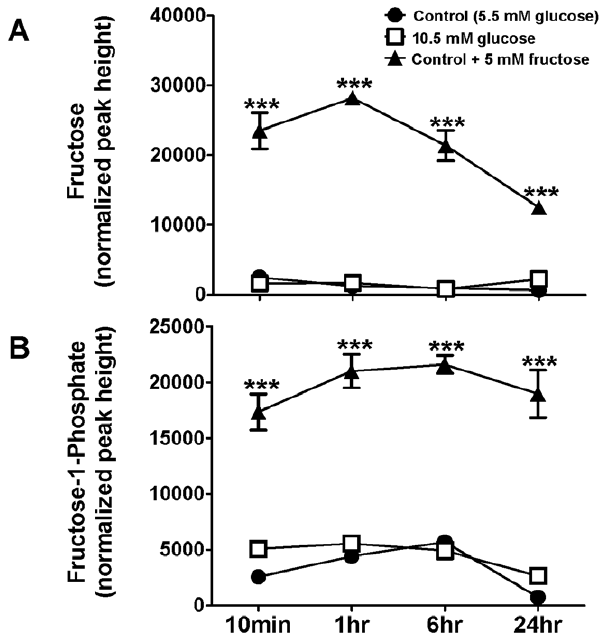
Figure 3. Cellular concentrations of UDP-GlcNAc in HepG2 cells following exposure to glucose and fructose or glucose alone. LC-QTOF results for cellular levels of UDP-GlcNAc in HepG2 cells at 10 min, 1 hr, 6 hr, or 24 hr time points following the addition of culture medium. The 10 mM GlcN condition, serving as a positive control, showed significant induction of the hexosamine biosynthesis pathway (HBP). Unit of intensity is quantifier ion peak height. Means 6 SEM are depicted. ***P , 0.001 vs. controls; n=3–6/group.